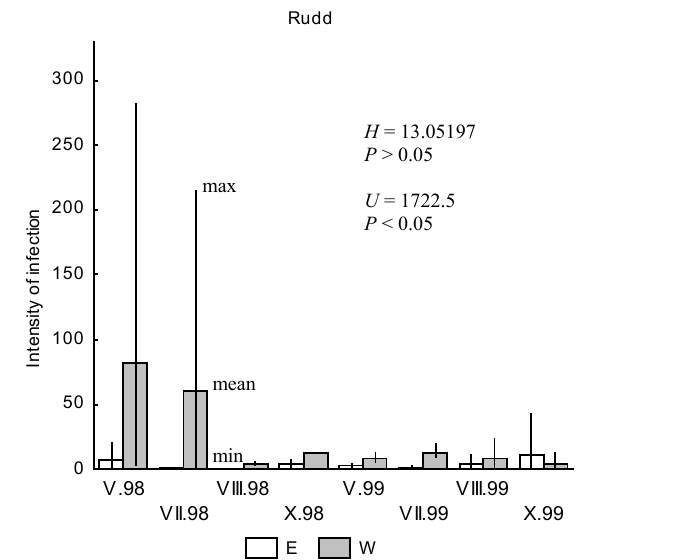
Fig. 4. Intensity of infection of rudd with P. cuticola in samples from eastern- (E) and western (W) part of OÊwin Lake; H , Kruskal–Wallis statistic for seasonal differences; U , Mann–Whitney statistic for location differences